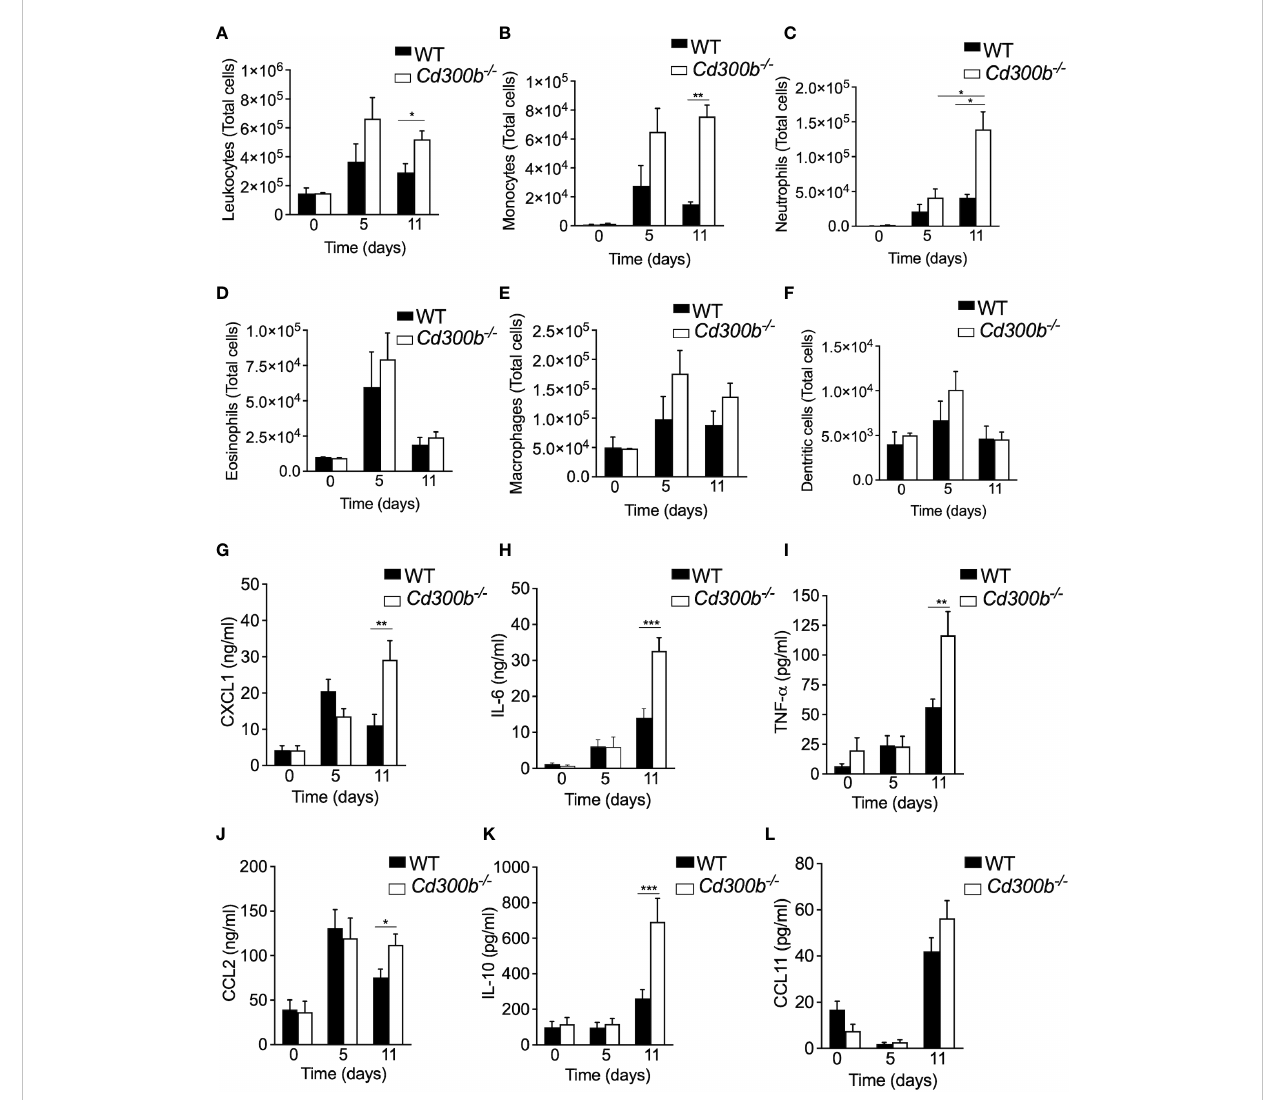
FIGURE 5 CD300b regulates colonic cellular in fi ltration and cytokine production. WT and Cd300b -\- mice were subjected to 2% DSS in their drinking water for fi ve days followed by six days of DSS-cessation and water administration. On days 0,5 and 11, the mice were euthanized, the colon obtained, enzymatically digested and the number of immune cells in the colon was analysed by fl ow cytometry (A – F) . Data are from n=3 experiments with 8- 10 mice. *p<0.05, **p<0.01, ***p<0.001. Colonic “ punch biopsies ” were obtained on days 0, 5 and 11, and incubated for 24 hours in culture medium. Levels of CXCL1 (G) , IL-6 (H) , TNF- a (I) , CCL2 (J) , IL-10 (K) , AND CCL11 (L) in the culture supernatants are shown. Data are from n ≥ 10 mice. *p<0.05, **p<0.01,